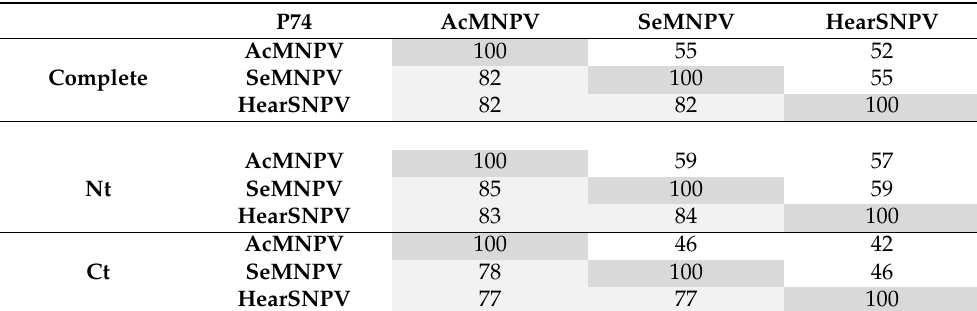
Values are expressed as percentages using whole numbers (“similarity” is shaded in light gray and “identity” is indicated by an uncolored background). “Complete” refers to the full protein, while “Nt” and “Ct” are respectively the amino and carboxyl terminal domains separated in the amino-acid triad WDP (containing at the nucleotide level a BamH I recognition site).